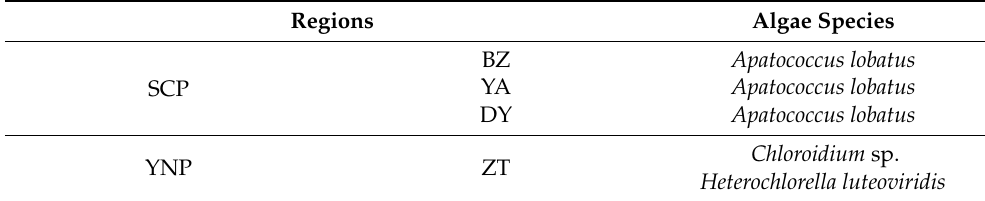
Table 9. The types of algae in different